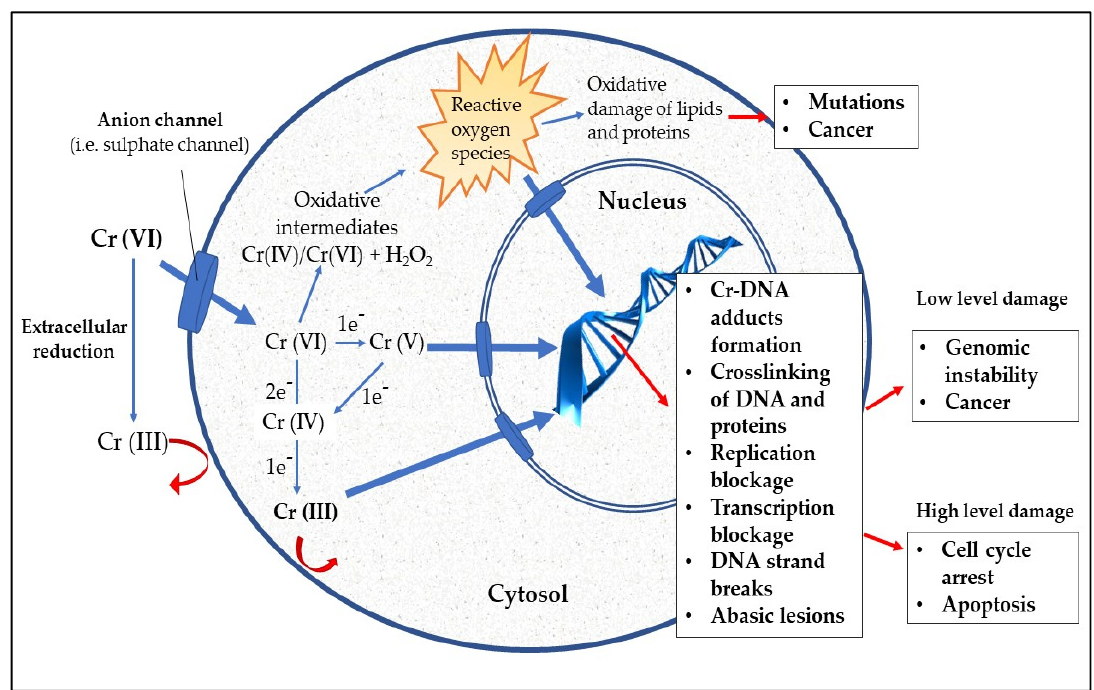
Figure 4. Cellular uptake and main pathways involved in chromium genotoxicity.